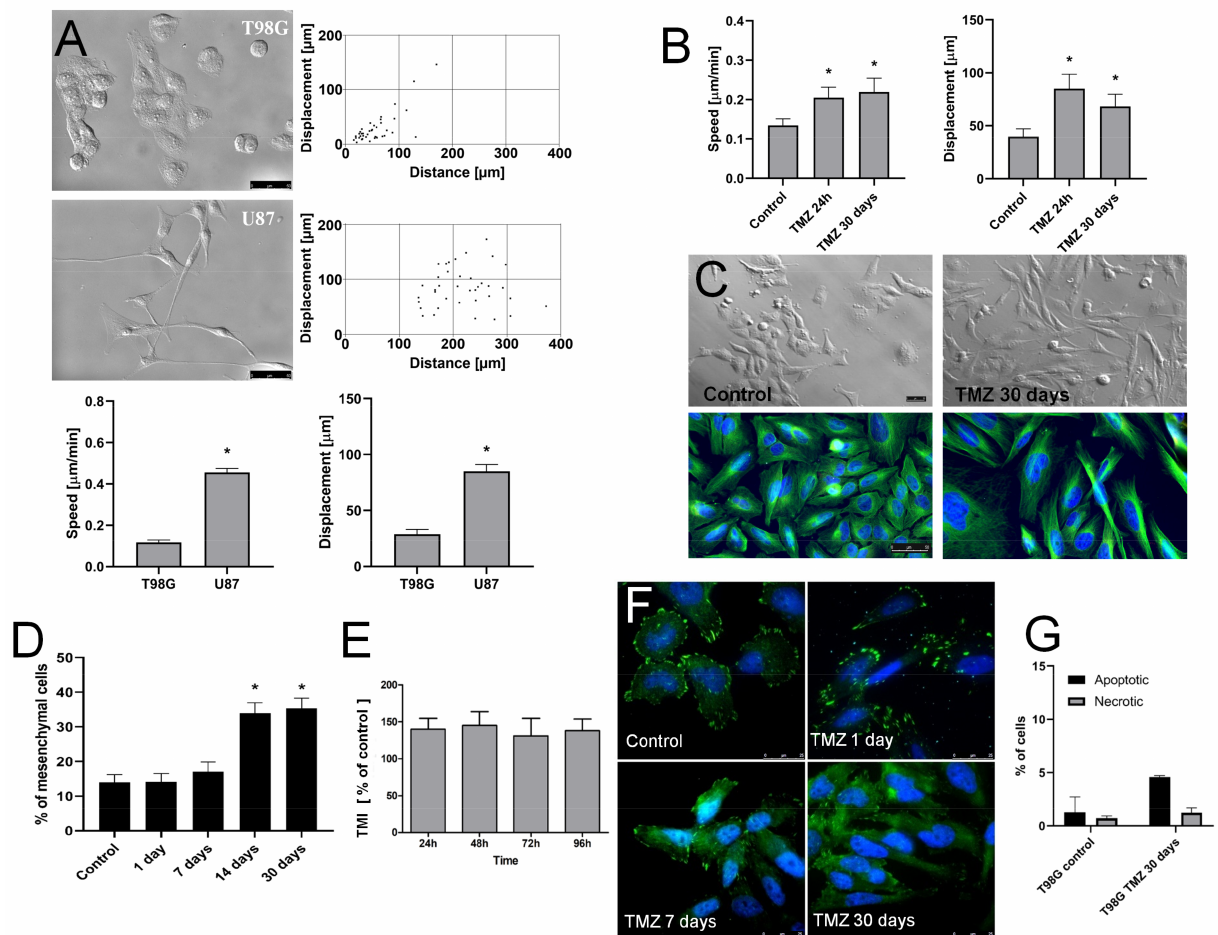
Figure 3. Long-term microevolution of invasive T98G cells under TMZ stress. ( A ) Comparison of innate morphology and motility of U87 and T98G cells estimated with immunofluorescence microscopy (tubulin-green/DNA-blue), Nomarski Interference Contrast (NIC) and time-lapse videomicroscopy. Dot-plots and bar graphs show trajectories, movement parameters at the single cell and population level, respectively (for circular diagrams, see Figure S3A). Scale bar 50 µ m. ( B , C ) T98G cells were cultivated in the presence of 25 µ M TMZ for one to 30 days. Their motility ( B ) and morphology ( C ) was estimated with time-lapse video and (NIC) microscopy, respectively. Architecture of microtubular cytoskeleton (tubulin-green/DNA-blue) was estimated with immunofluorescence (see also Figure S3B,C). Scale bar 50 µ m. ( D ) T98G cells were cultivated in the presence of 25 µ M TMZ for 1–30 days. The fractions of mesenchymal (rear-front polarized) cells (upper panel) and Snail-1 levels (lower panel) were then estimated with morphometric and immunofluorescence assays. ( E ) Invasive potential of T98G cells undergone the long-term (30 days) TMZ-treatment in vitro. Cells were seeded into the inserts, the number of cells that transmigrated through the membranes was estimated at the indicated time points and calculated in relation to naive T98G cells. ( F ) Naive T98G cells and their TMZ-treated (one, seven, and 30 days) counterparts were prepared as in Figure 1A and Cx43 levels were analyzed with immunofluorescence. Scale bar 25 µ m. ( G ) Cells were treated with 25 µ M TMZ for one and 30 days and their apoptotic response was estimated with AnnexinV/PI assay. At least 5000 single cells were analyzed, gated according to their area/aspect ratio. Statistical significance was calculated with ANOVA/non-parametric Mann–Whitney test, * p < 0.05 vs. control. Data are representative of three independent experiments. Note the relatively TMZ-resistance of MGMT high T98G cells and the microevolution of invasive Cx43 high T98G lineages under persistent TMZ